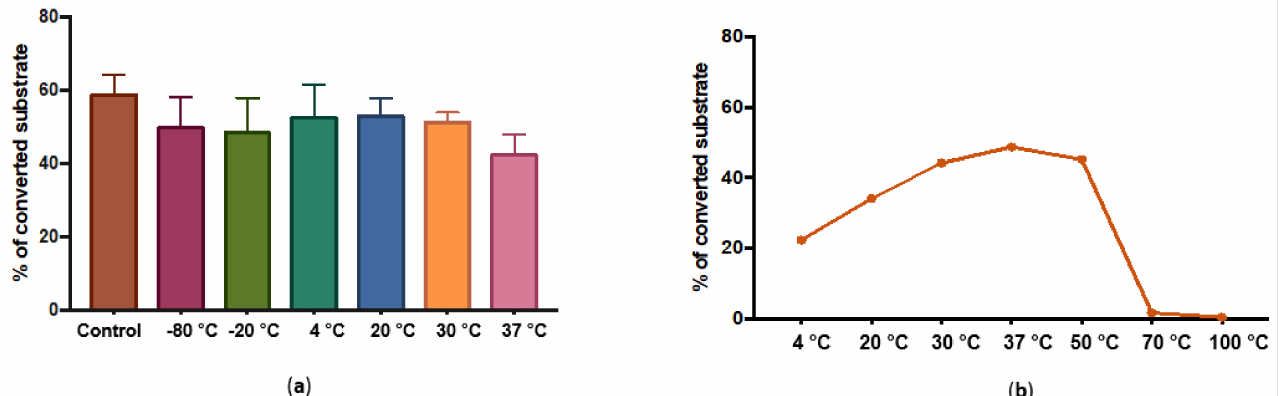
Figure 2. Effect of temperature on enzymatic activity ( a ) Effect of incubation at different temperatures; ( b ) Effect of overnight storage in different temperature on activity.